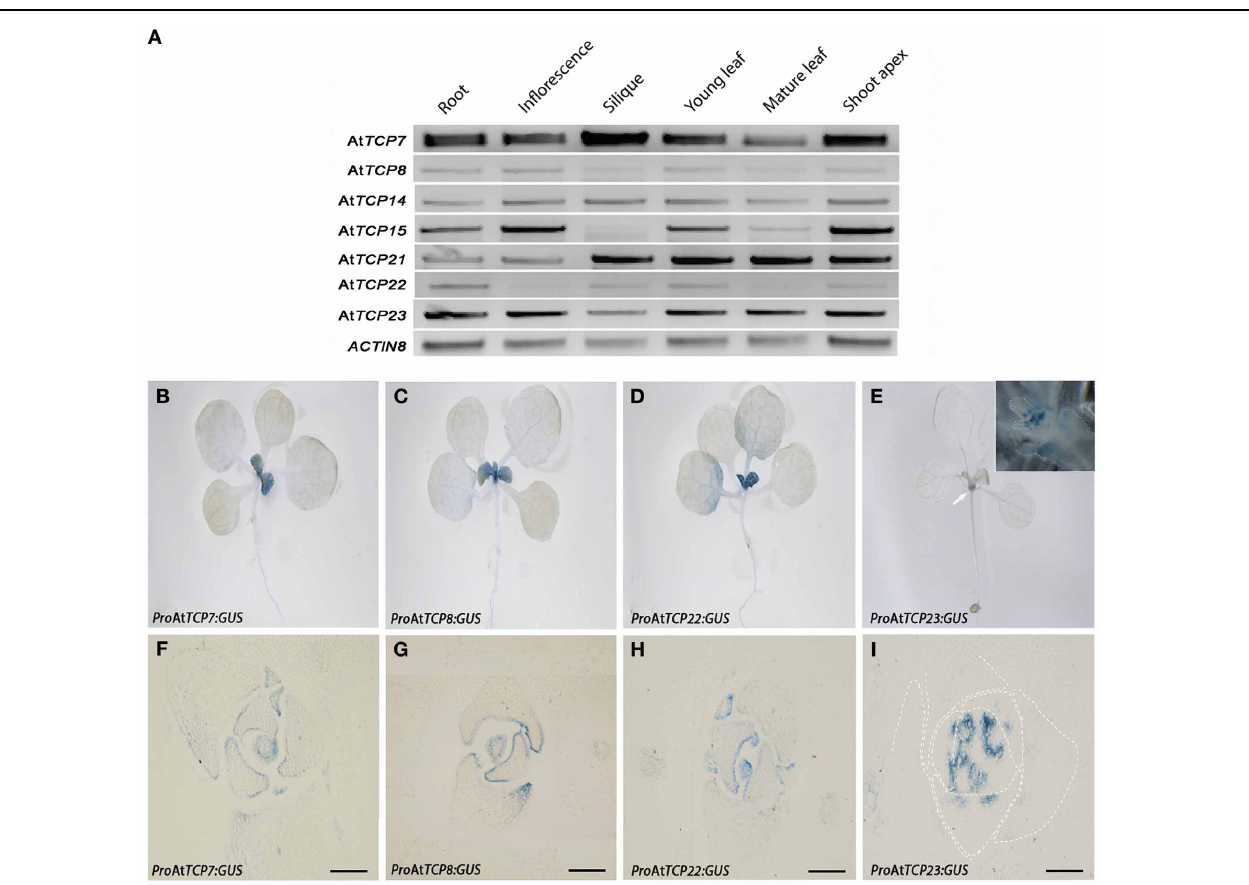
FIGURE 2 | Expression pattern of class I TCP genes. (A) RT-PCR analysis of the tissue expression of class I TCP genes. ACTIN8 was used as control gene. (B–I) Analysis of the expression pattern using the reporter marker uidA fused to the promoters of the genes in 12 days-old T3 transgenic plants. (B) Pro At TCP7:GUS ; (C) Pro At TCP8:GUS ; (D) Pro At TCP22:GUS ; (E)